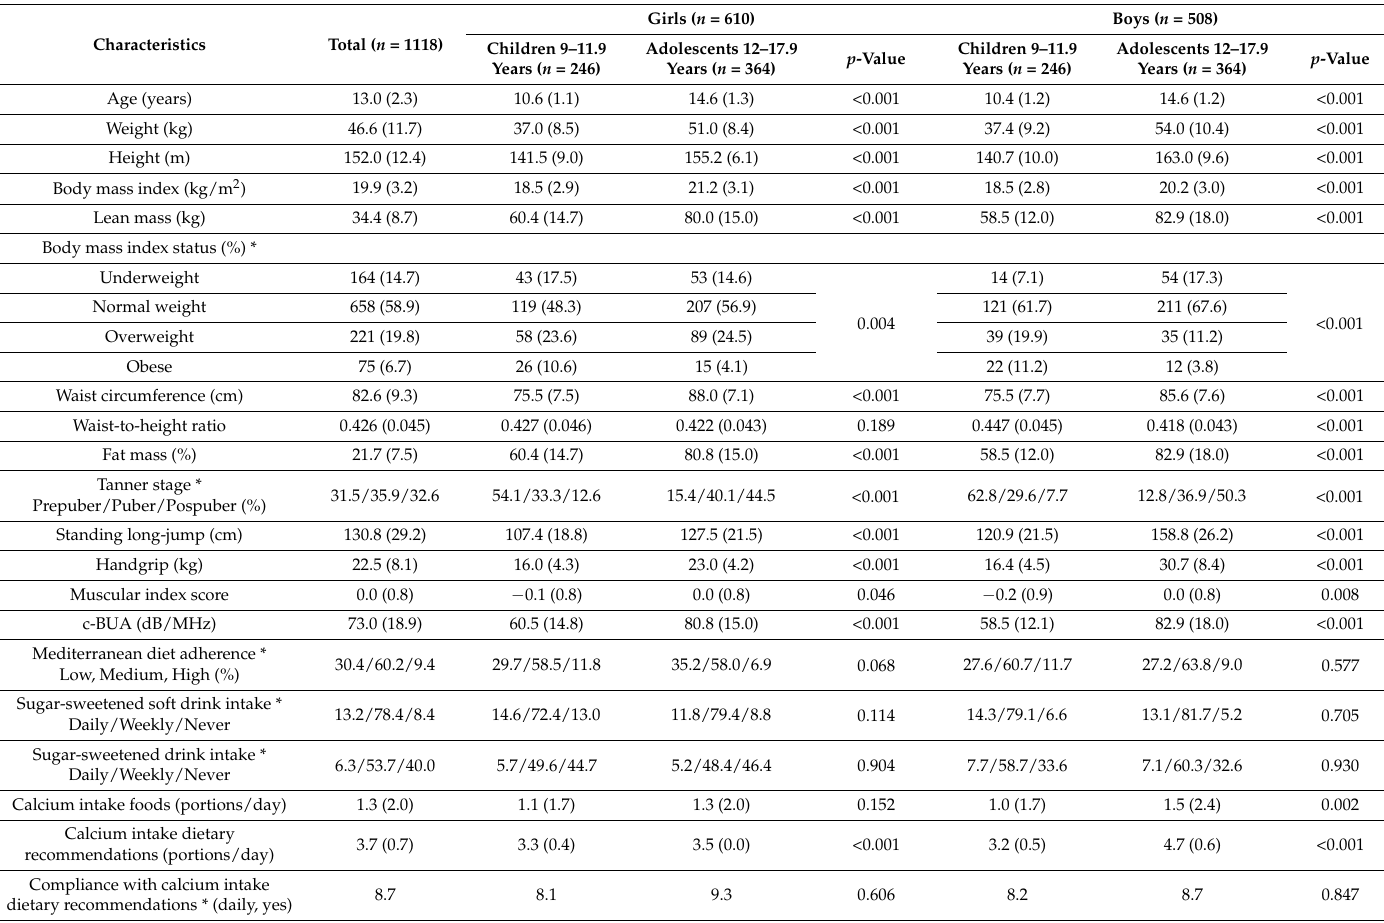
Table 1. Characteristics among a sample of children and adolescents from Bogota, Colombia (mean (SD) or